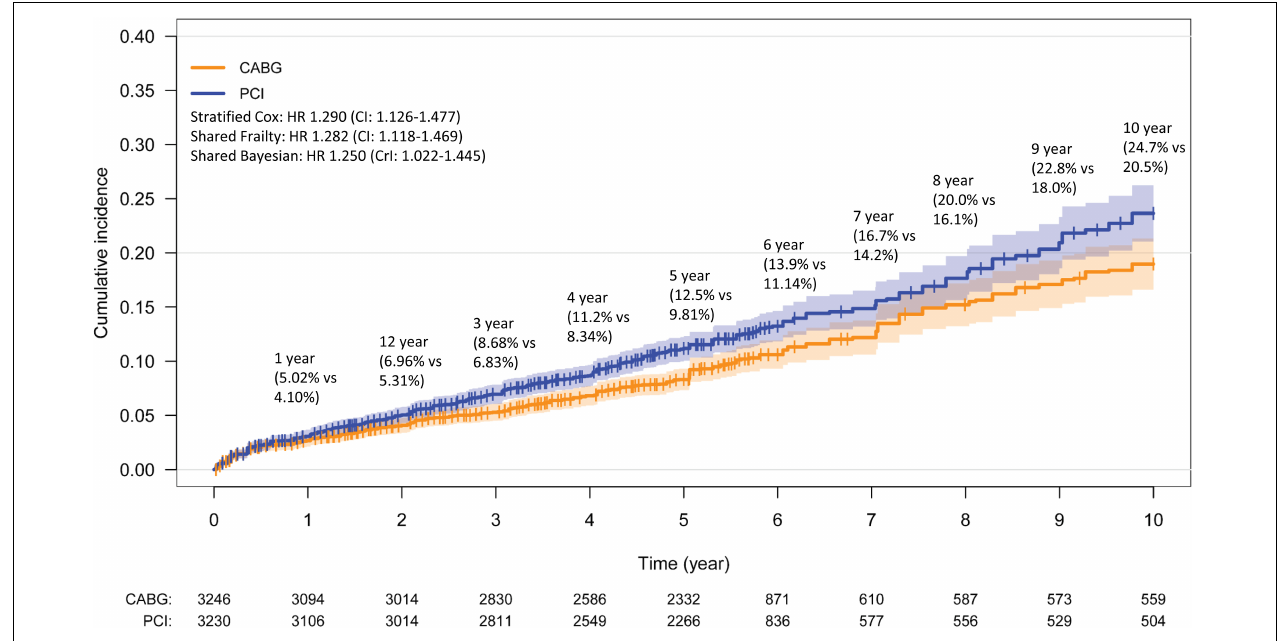
FIGURE 3 | Kaplan–Meier curve for all-cause mortality. Kaplan–Meier estimates for all-cause mortality from the overall pooled patient population. CABG, coronary artery bypass graft; PCI, percutaneous coronary